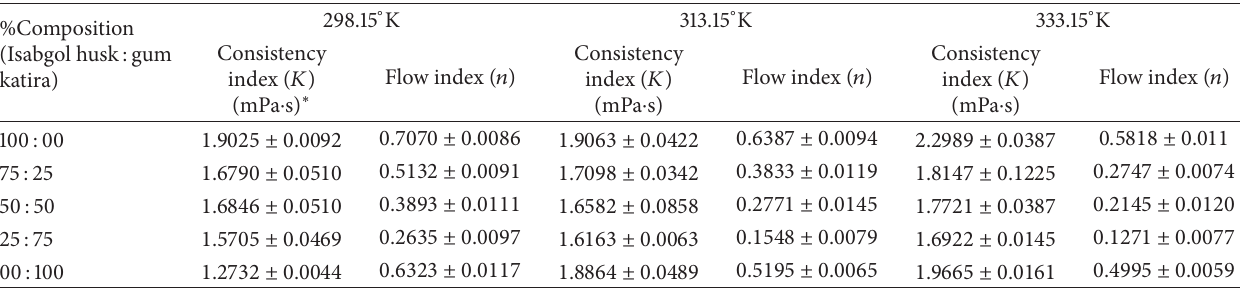
Average of three successive results ( 𝑛 = 3 ) and “ ± ” value is the standard deviation. Table 3: Consistency index ( 𝐾 ) and flow index ( 𝑛 ) of blends in 1:1 mass% of Isabgol husk and gum katira at 298.15 ∘ K, 313.15 ∘ K, and 333.15 ∘ K.